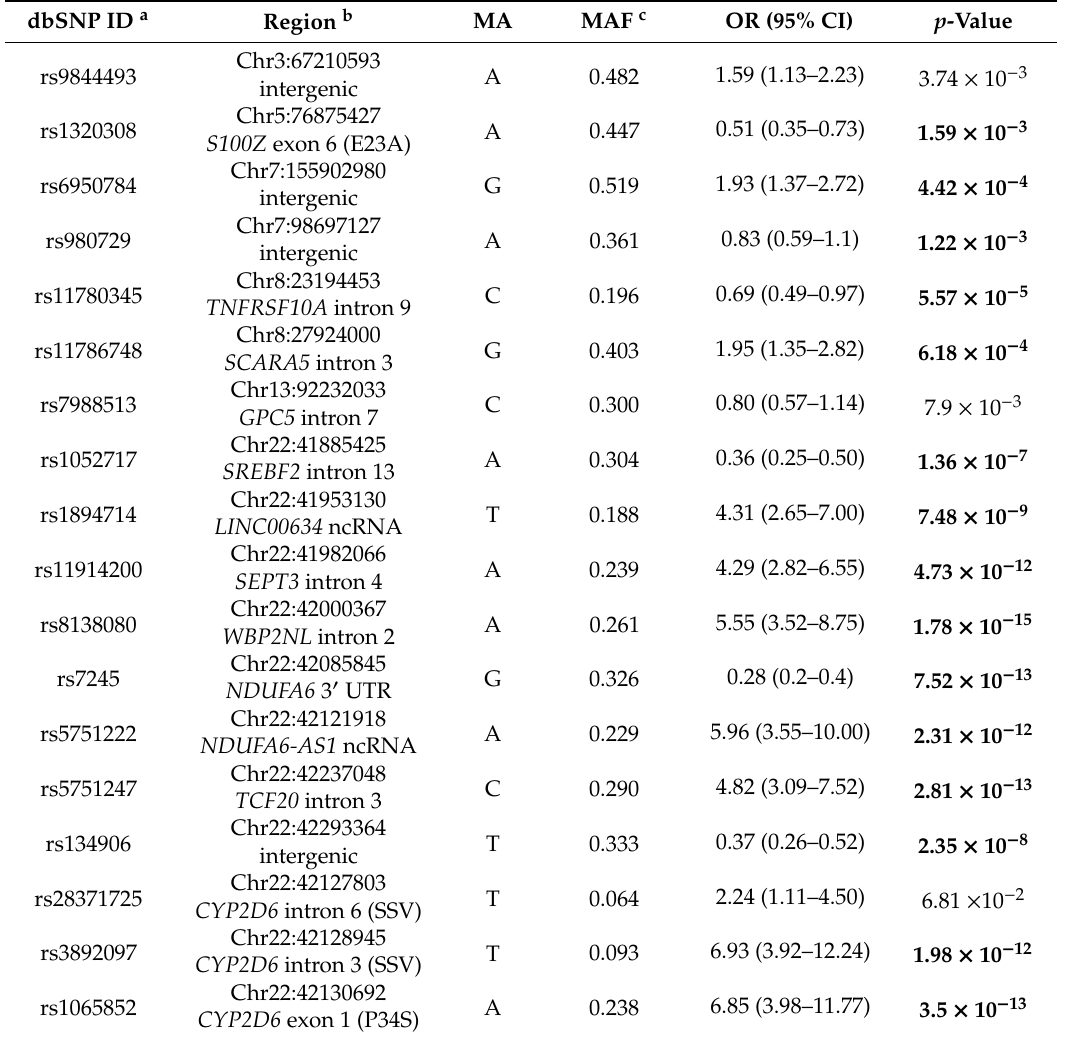
Table 2. Verification analysis of genome-wide association study (GWAS)-selected SNPs and the most frequent CYP2D6